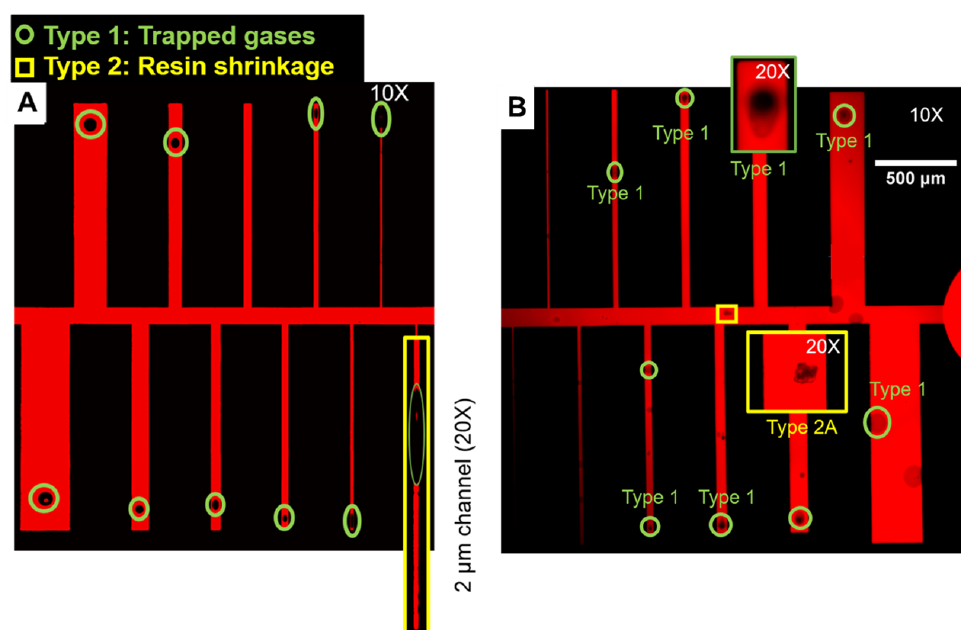
Figure 8. Confocal images of silicon micromodels impregnated by resin mixed with a fluorescent dye. Impregnation is carried out at: vacuum ( A ) and at high pressure ( B ). Type 1 defects (gas bubbles) trapped during the inefficient impregnation are highlighted inside the channels of both micromodels. Type 2 defects were only observed in the high-pressure impregnated model.